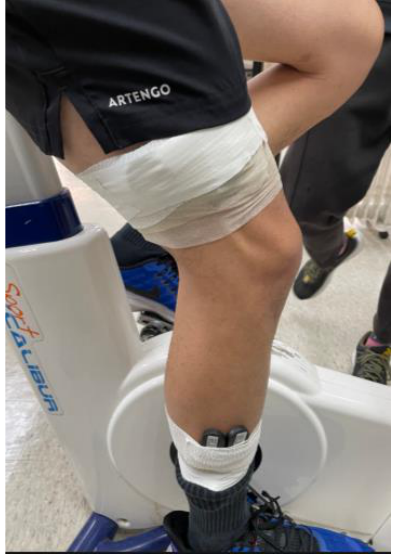
Figure 20. Sensors installed on the upper and lower parts of the leg.